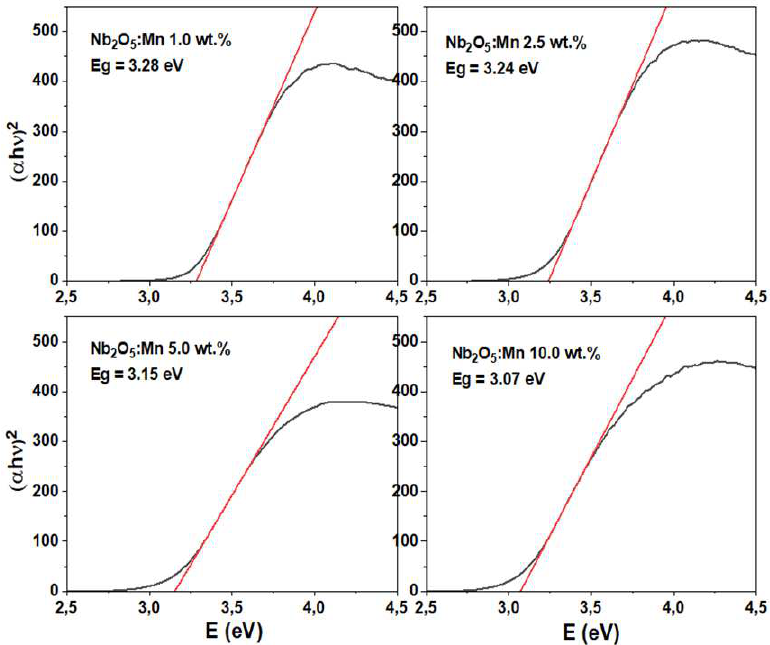
Figure 8. Kubelka–Munk transformed reflectance spectra of annealed samples at 700 ◦